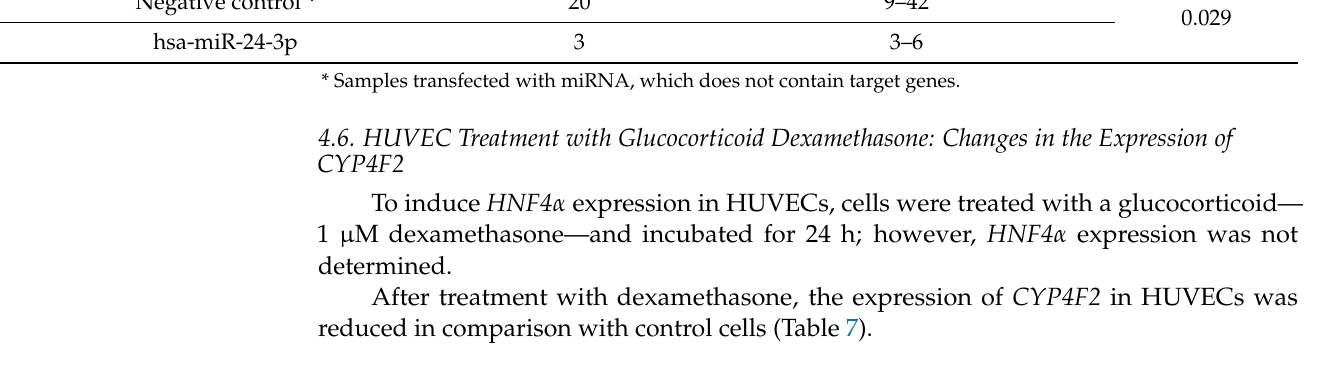
Table 7. Relative changes in the expression ( ∆ Ct) of CYP4F2 after exposure to 1 µ M dexamethasone in HUVECs compared to control